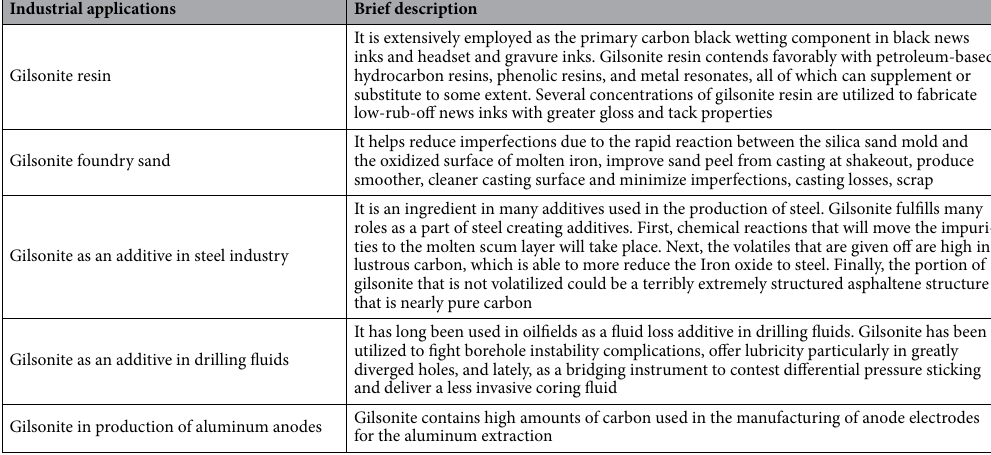
Table 1. Some example of specific industrial applications for gilsonite with a low ash (<